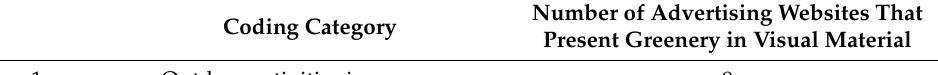
Table 6. The number of advertising websites that present greenery in a visual material in the three coding